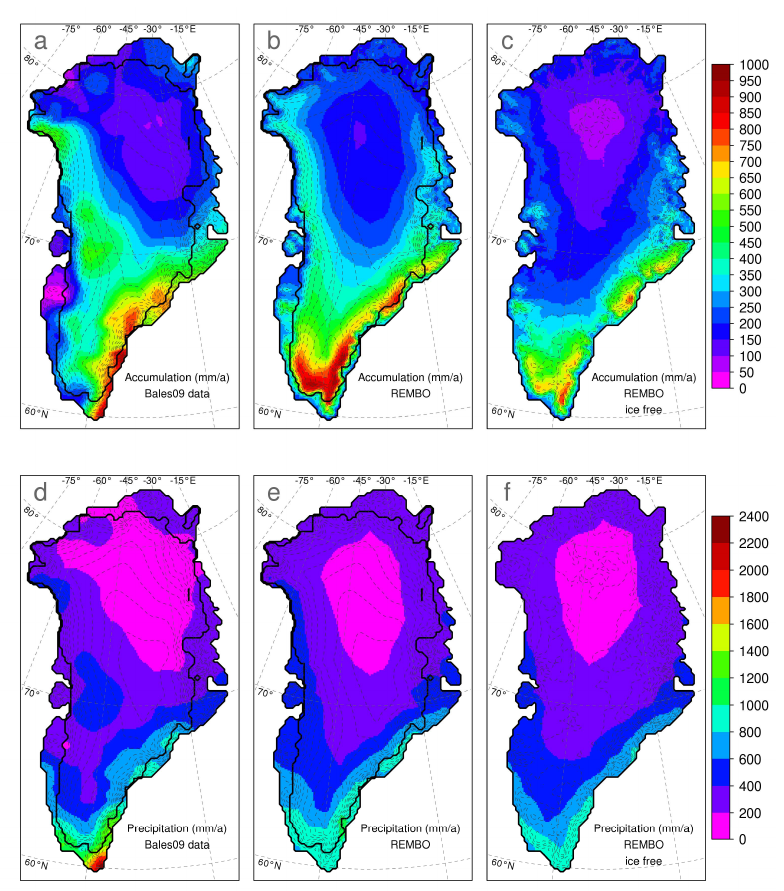
Fig. 4. Greenland accumulation fields from (a) present-day data, (b) REMBO for present-day topography and (c) REMBO for ice-free, uplifted bedrock topography. Total precipitation fields for the same are shown in (d), (e) and (f), respectively. Elevation contours are shown at 300 m intervals.